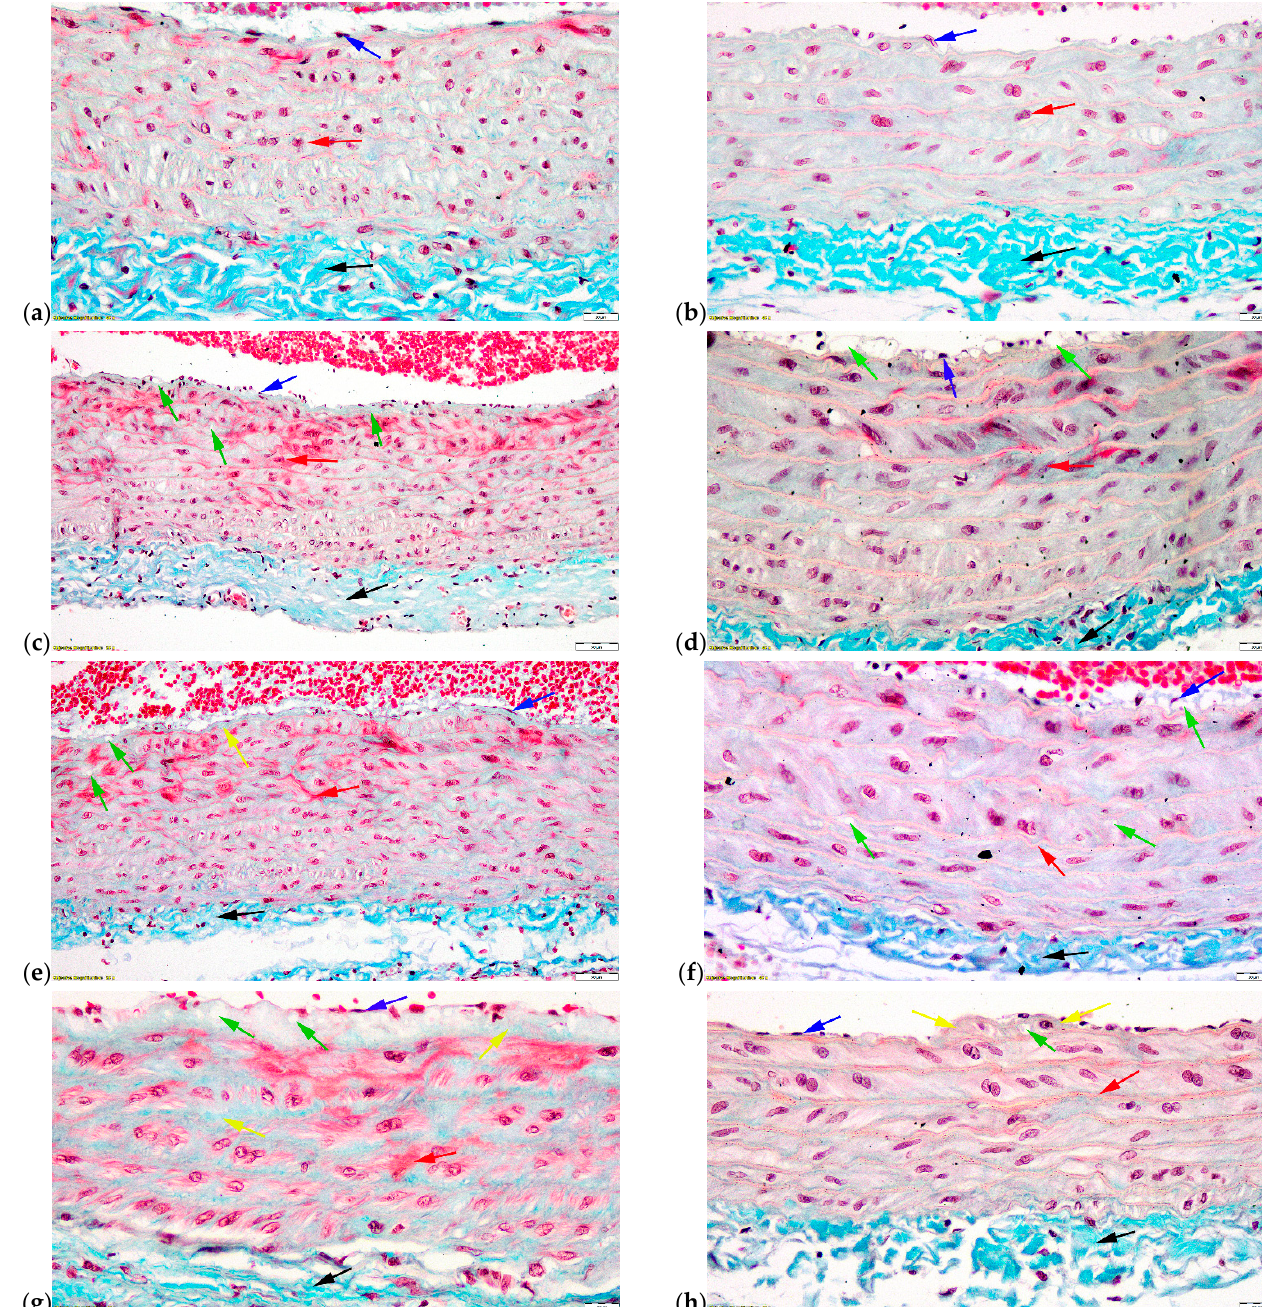
Figure 7. Histopathological examination of the aorta. ( a ) Control group—The base of the heart (the ascending aorta); ( b ) Control group—Descending aorta (the thoracic segment); ( c ) Hypertension group—The base of the heart (the ascending aorta); ( d ) Hypertension group—Descending aorta (the thoracic segment); ( e ) Dyslipidemia group—The base of the heart (the ascending aorta); ( f ) Dyslipidemia group—Descending aorta (the thoracic segment); ( g ) Type 1 diabetes mellitus group—The base of the heart (the ascending aorta); ( h ) Type 1 diabetes mellitus group—Descending aorta (the thoracic segment). Blue arrow—tunica intima; red arrow—tunica media; black arrow—tunica adventitia; green arrow—lipid droplets; yellow arrow—tendency to fibrosis.